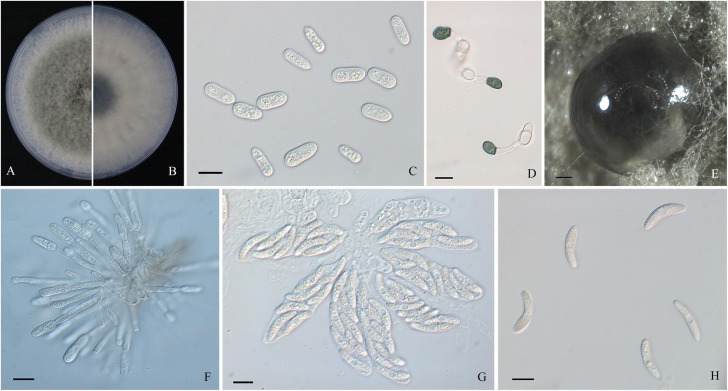
Morphological characters of Colletotrichum fructicola. (A,B) Front and back view, respectively, of 6-days-old PDA culture. (C) Conidia. (D) Appressoria. (E) Ascomata developed on PDA plates. (F) Conidiophores. (G) Asci. (H) Ascospores. Scale bars: (C,D,F–H) = 10 μm; (E) = 200 μm.